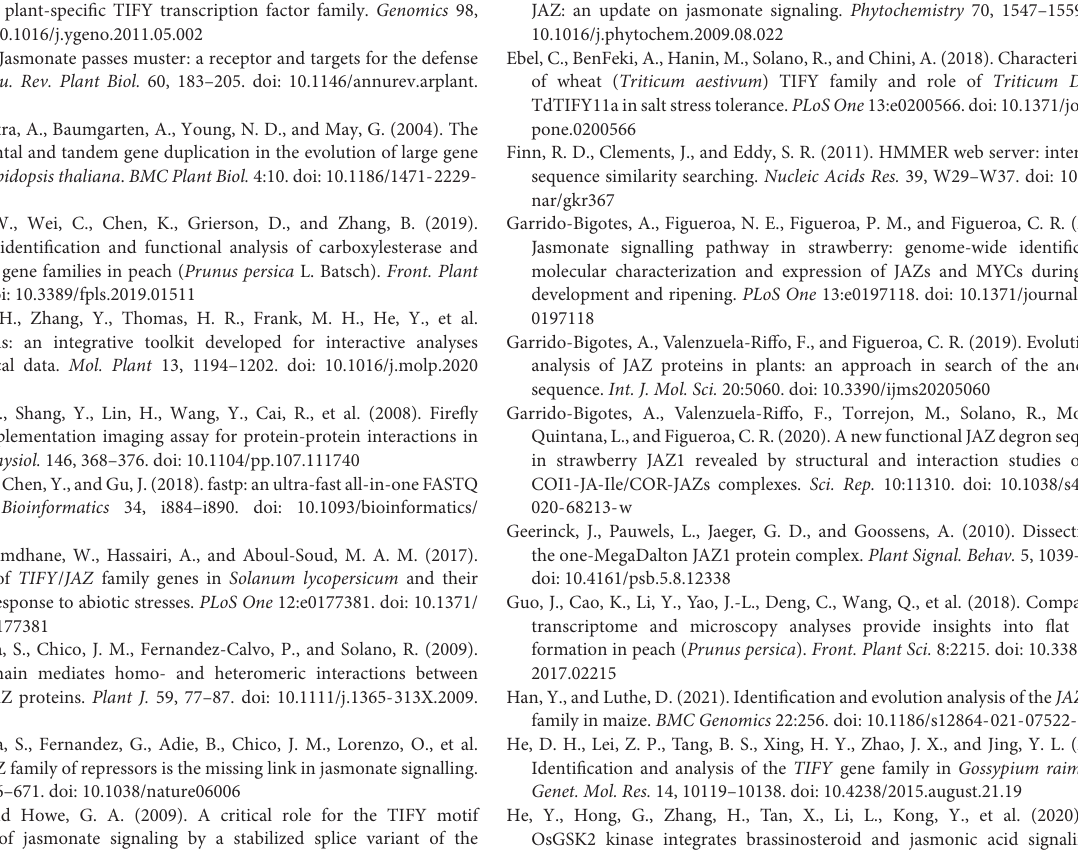
Supplementary Table 2 | Hits obtained by searching the peach genome v2.0 sequences using the Hmmsearch software of the HMMER suite. Hidden Markov model (HMM) profiles of the TIFY domain, the Jas (CCT-2) motif and the CCT motif were extracted from the Pfam database (accession numbers PF06200, PF09425, and PF06203, respectively). Supplementary Table 3 | Scanning of the conserved domains of the JAZ, PPD and ZML subfamily members in the SMART database. Supplementary Table 4 | Comparative syntenic analysis between peach and apple genomes. Supplementary Table 5 | Expression levels (TPM) of TIFY family genes that derived from RNA-Seq data downloaded from NCBI SRA database. Average and standard derivation (SD) of the means were calculated using three biological replicates. For more details see the section “Materials and Methods”. Supplementary Table 6 | Expression levels (TPM) of TIFY family genes that derived from RNA-Seq data downloaded from NCBI SRA database